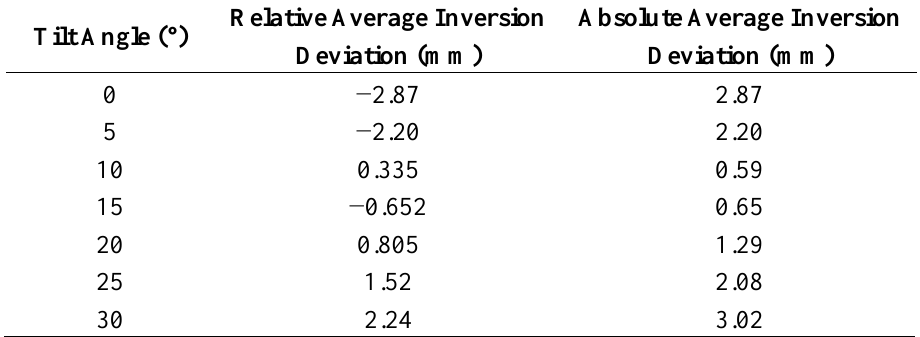
Table 3. Comparison of the inversed and the measured values of horizontal displacement ( Z = 125 0